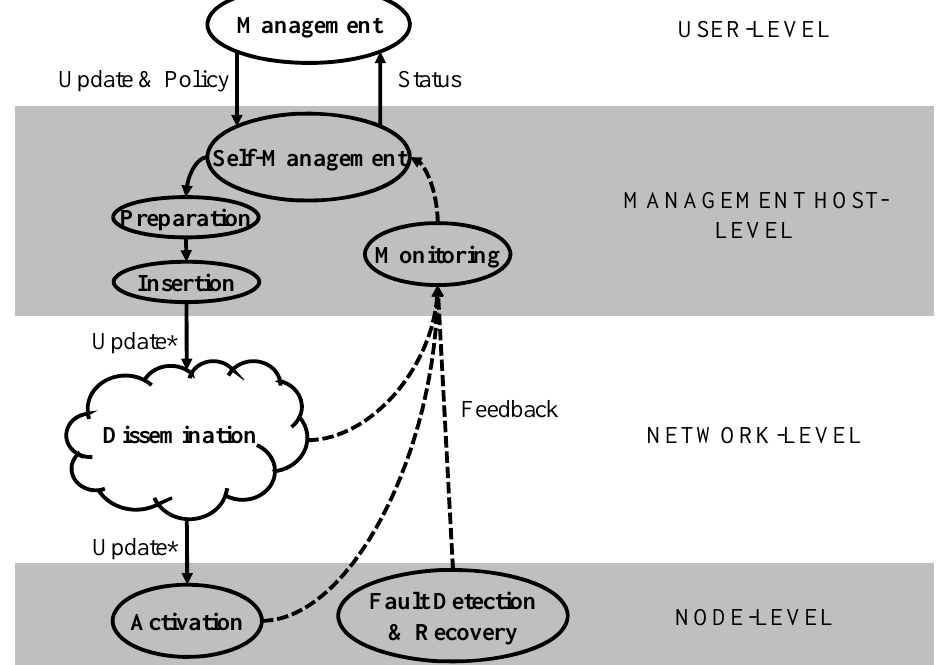
Figure 1. Autonomous Update